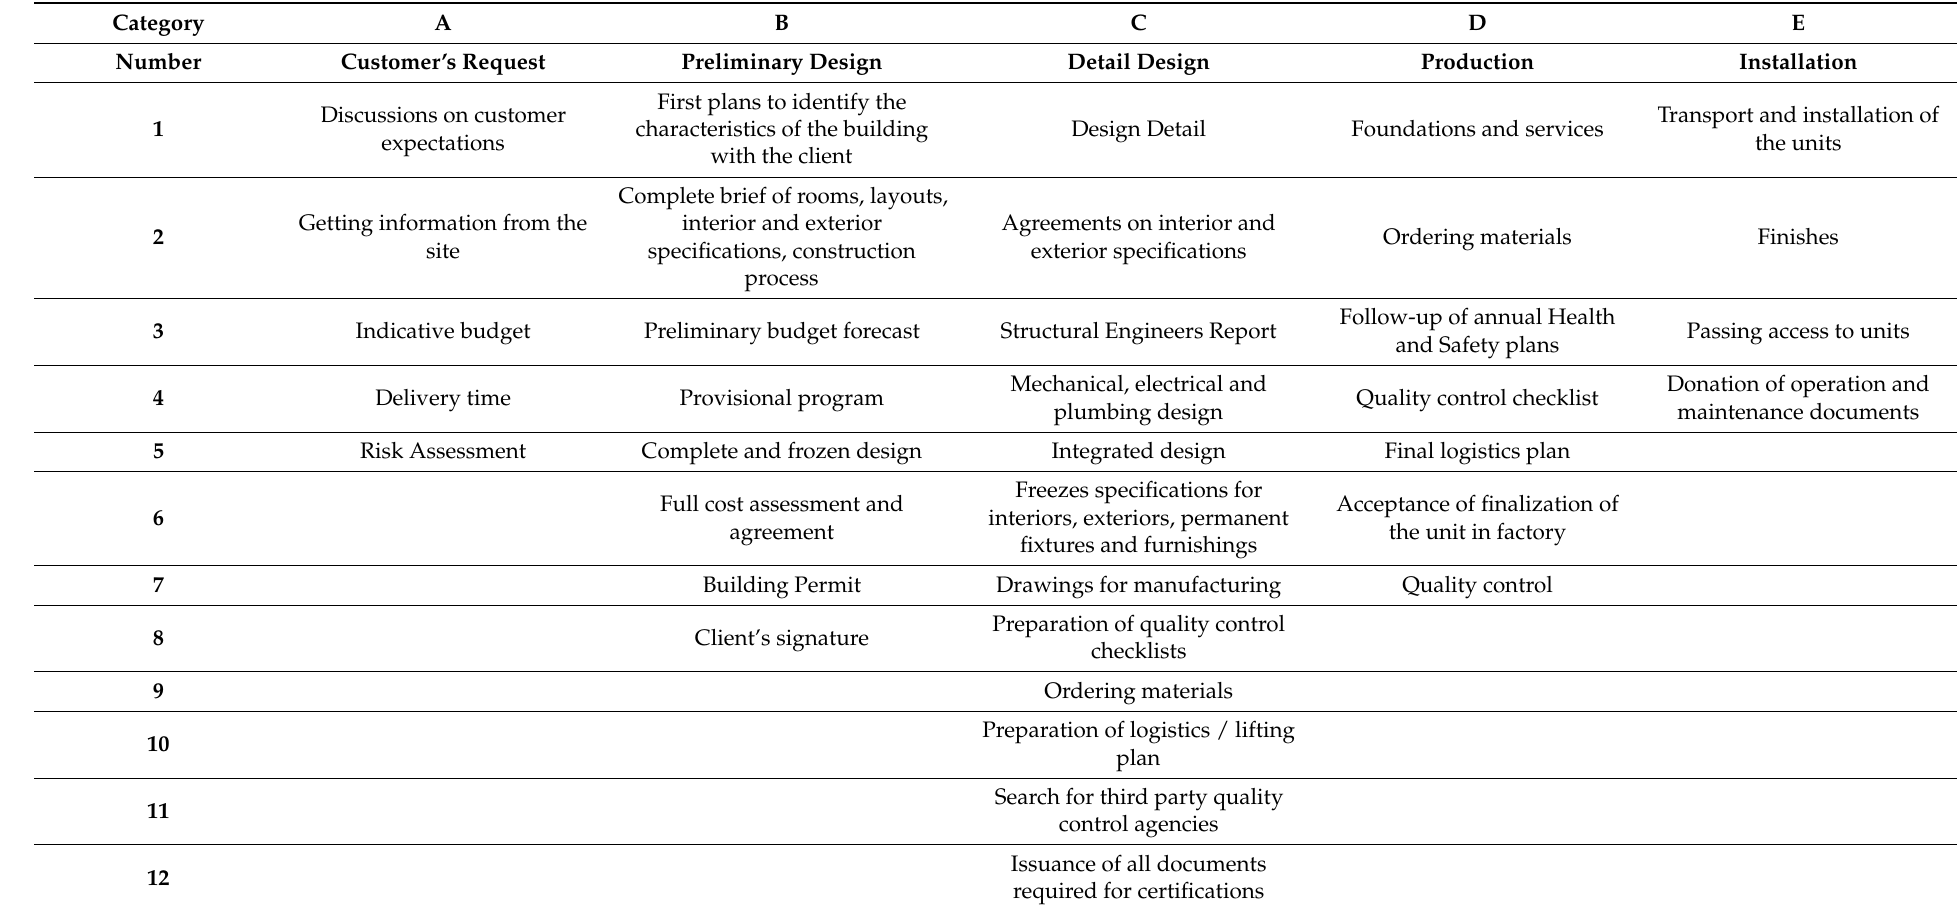
Table 1. Prefabricated construction project sequence with task